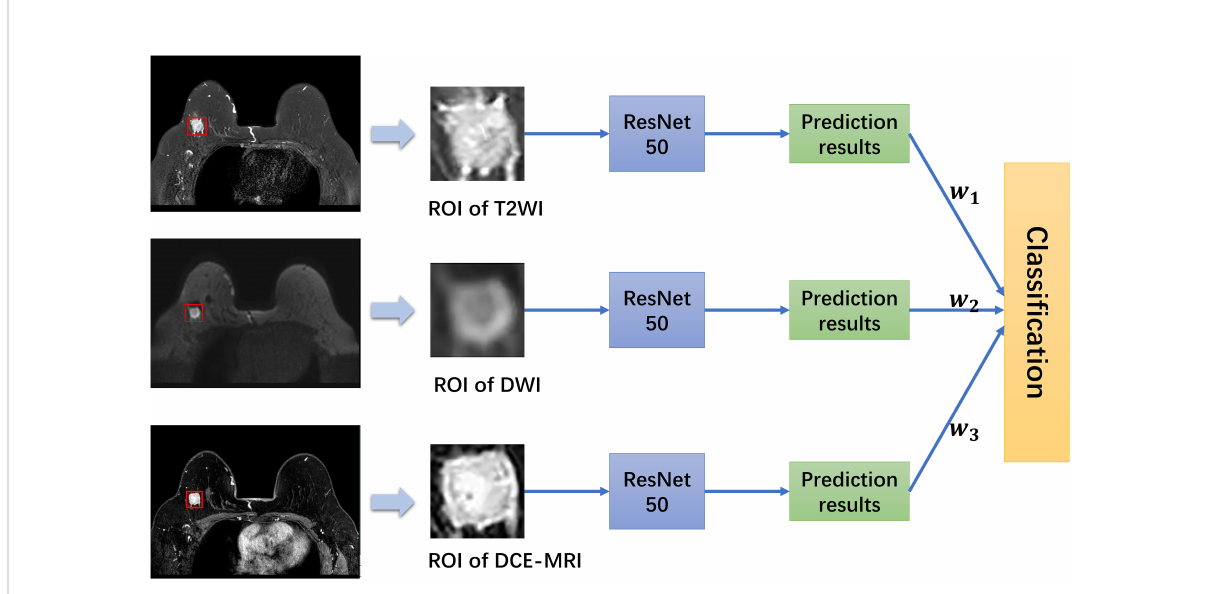
FIGURE 4 Work fl ow and the whole structure of the multiparametric MRI model. w represents the weight of each base